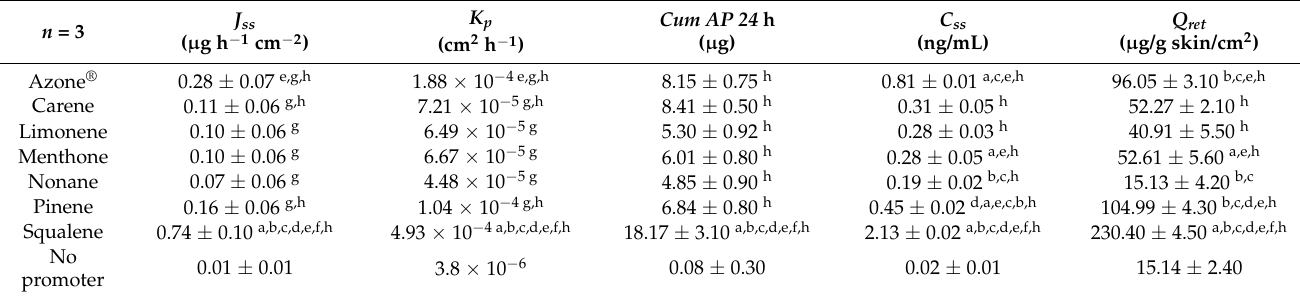
Table 7. Biopharmaceutical parameters of Apremilast-solutions with and without penetration enhancer.